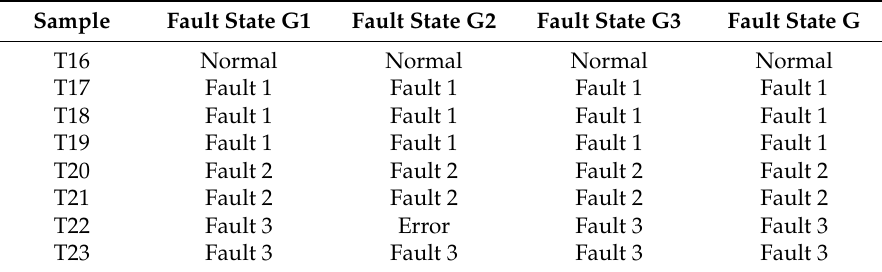
Table 4. The output results of the fault